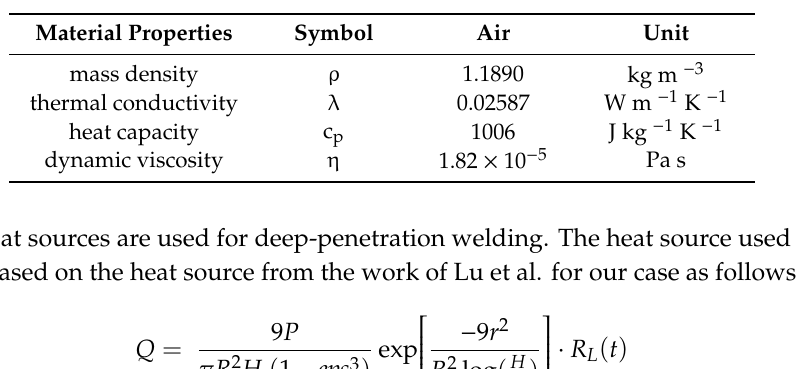
Table 2. Material properties of air at room temperature based on [15].